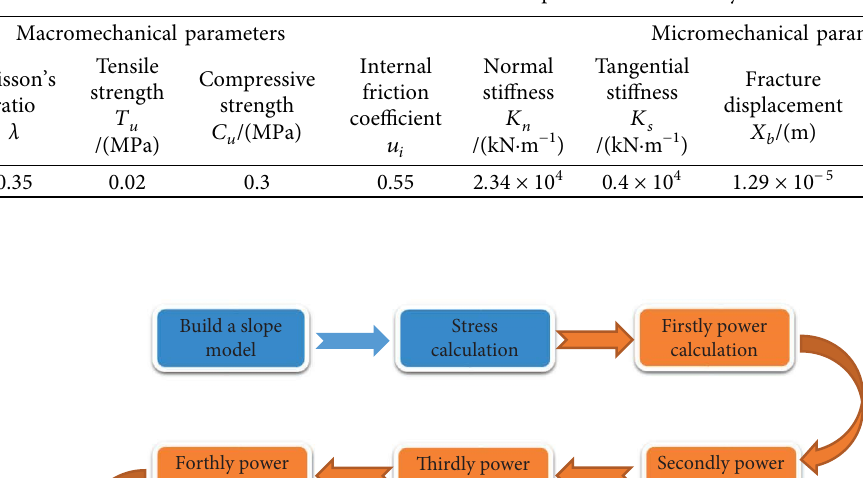
Table 2: Macro and micromechanical parameters of soil layer.